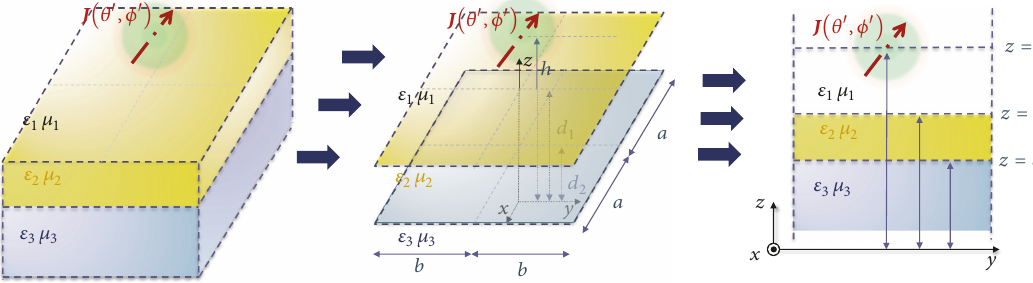
Figure 3: Definition of the analysis cell. (Left) 3D view of the three layers (microfluidic region (1) , gold layer (2) , and prism (3) ) and one point dipole. (Middle) 3D view of the interfaces and geometry of the unit cell. (Right) Side view of the unit cell.